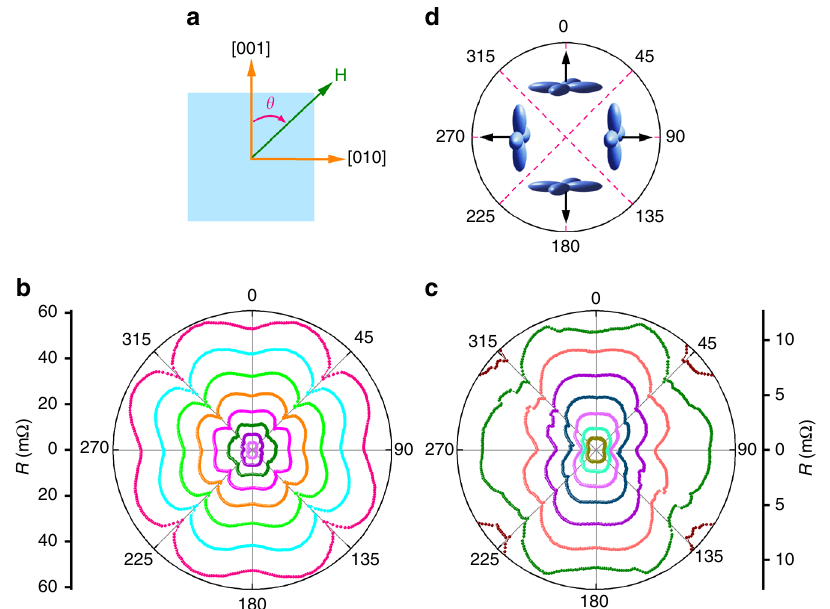
Fig. 1 Magnetic- fi eld dependent anisotropic magnetoresistance. a Schematic showing the de fi nition of the angle θ for the magnetic fi eld orientation. The magnetic fi eld is rotated in the (100) plane while the current fl ows along the [100] direction, i.e., they are always perpendicular to each other. b Polar plot of the angle-dependent resistance of Sample A at T = 3 K in magnetic fi elds of μ 0 H = 9T to 2T in intervals of 1T. The data clearly show the minima in the ferromagnetic phase at μ 0 H ≥ 5T at θ = 45°, 135°, 225° and 315° degrees induced by orbital- fl op, in addition to the minima at θ = 0°, 90°, 180° and 270° degrees originating from the Fermi surfaces. c Polar plot of the anisotropic magnetoresistances of the same sample at the same temperature in antiferromagnetic phase from μ 0 H = 4T to 1T (and partial data at 4.5T) in intervals of 0.5T. The data show more complicated features resulting from the competition of orbital- fl op, anisotropic Fermi surface and magnetic phase transitions. d Schematic showing the orientations of the Ce Γ ð 1 Þ blue crosses) that fl ops at θ = 45°, 135°, 225° and 315° degrees. Black arrows represent the magnetic moment